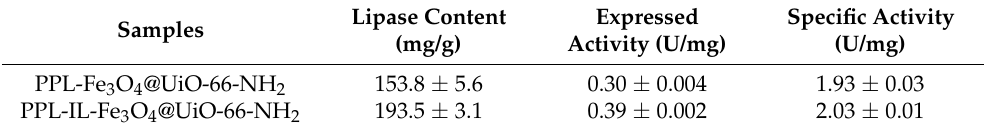
Table 1. Results of the immobilized